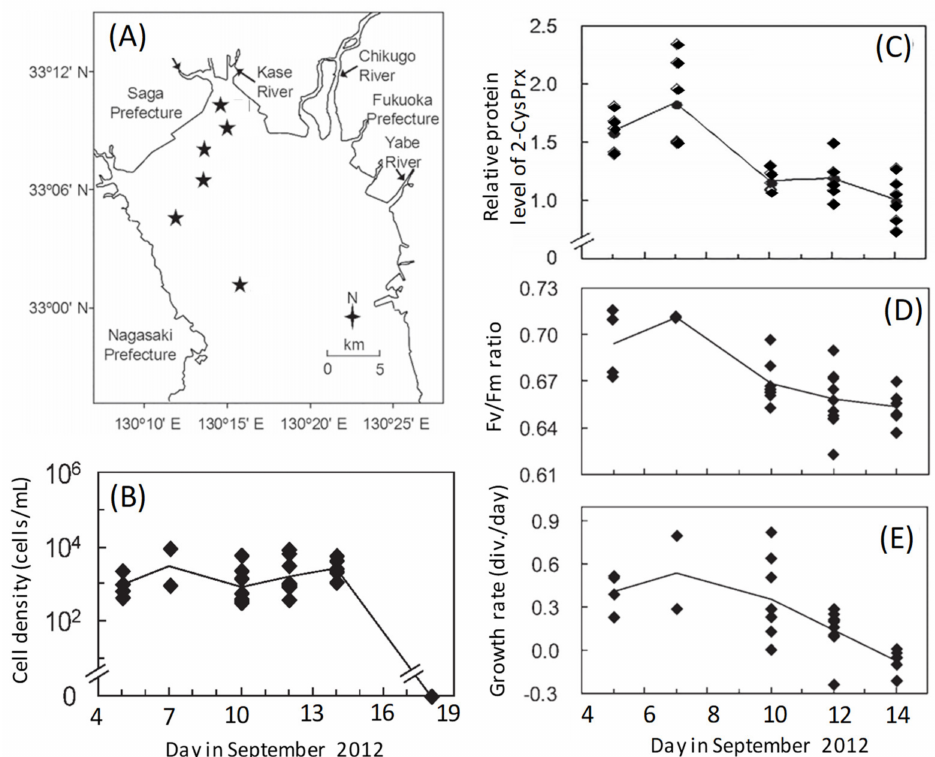
Figure 3. Field sites for sampling from 5 to 18 September 2012 in the inner part of the Ariake Sea, Japan ( A ). Stars indicate the sampling stations. Temporal variations of the ( B ) cell concentrations, ( C ) relative 2-CysPrx expression levels, ( D ) photosynthetic activities (Fv/Fm ratios), and ( E ) growth of Chattonella marina cells in natural seawater samples. Growth rates were calculated from the change of cell concentrations between the sampling day and the next day after incubation in a growth chamber. Symbols indicate values for each station, and lines indicate the average values of all stations on the same sampling day